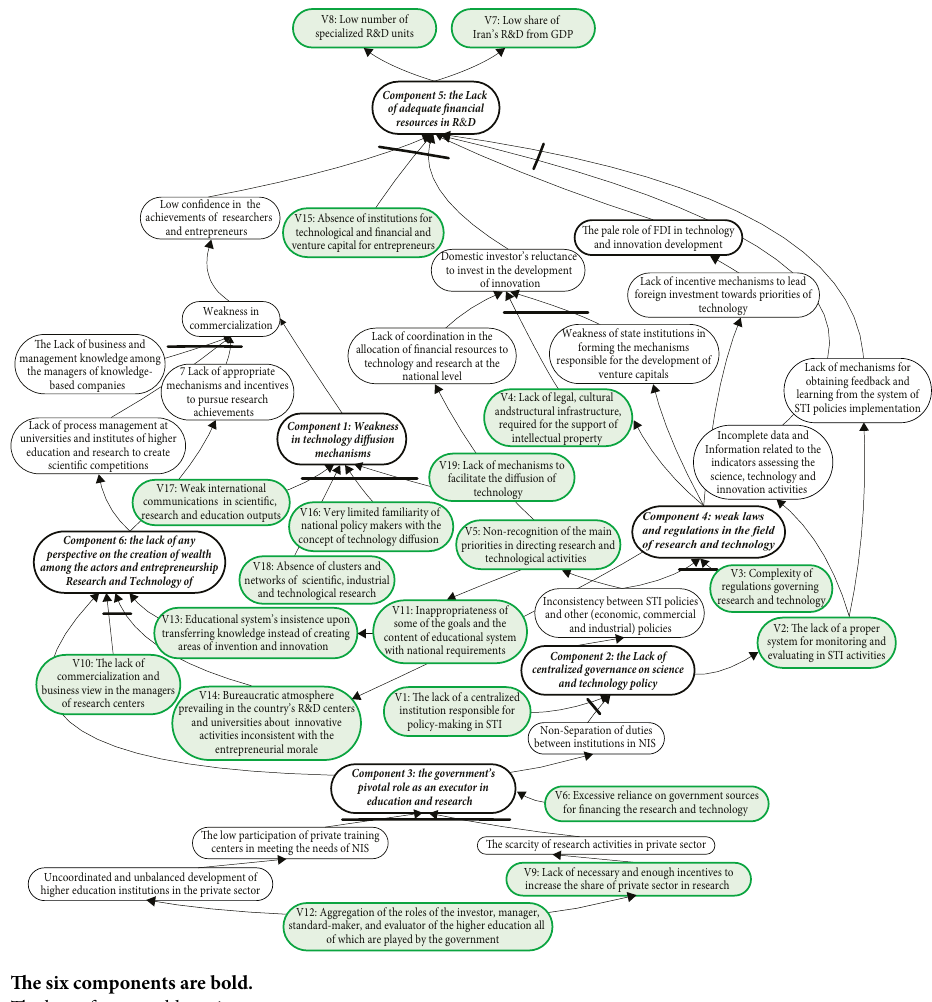
Fig. 2. Current Reality Tree of Iran’s